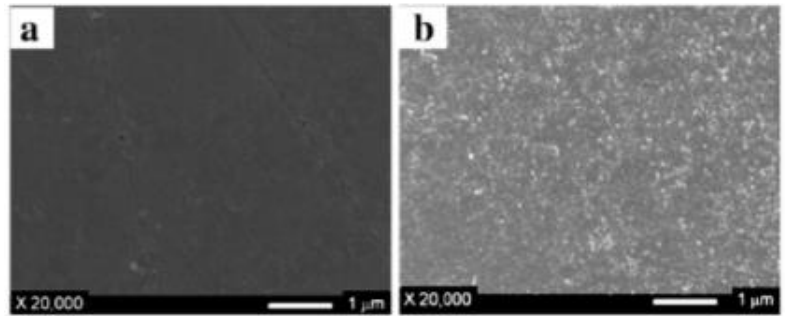
Figure 8. SEM images of ( a ) unmodified membrane, and ( b ) PDA (0.1 kg / m 3 ) modified AEM. Reproduced with permission from [73].